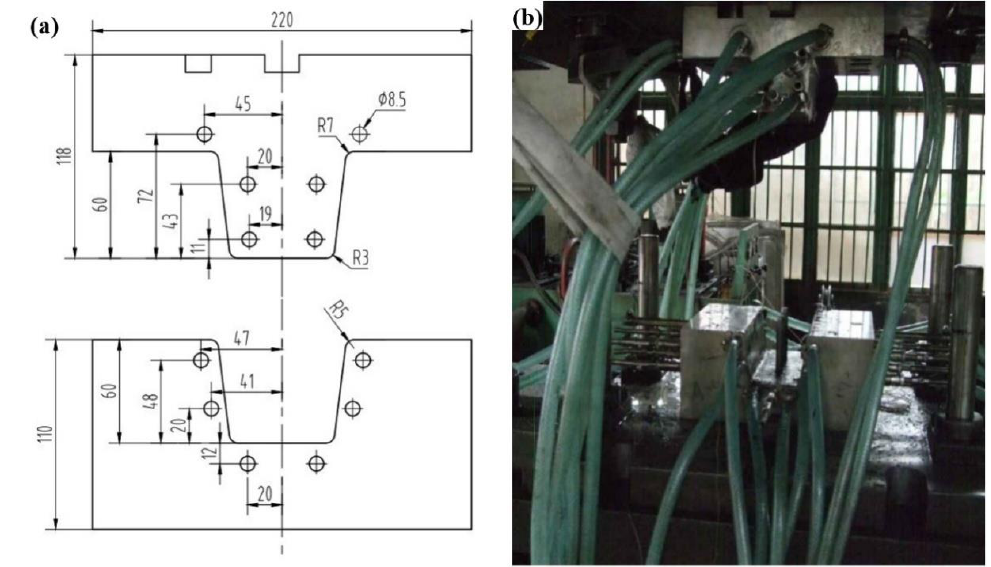
Figure 9. Schematics of ( a ) thermoforming die and ( b ) water-cooling system.